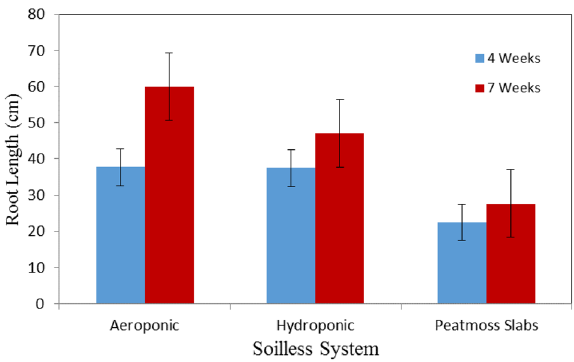
Figure 4. The root length of basil plants grown in different soilless